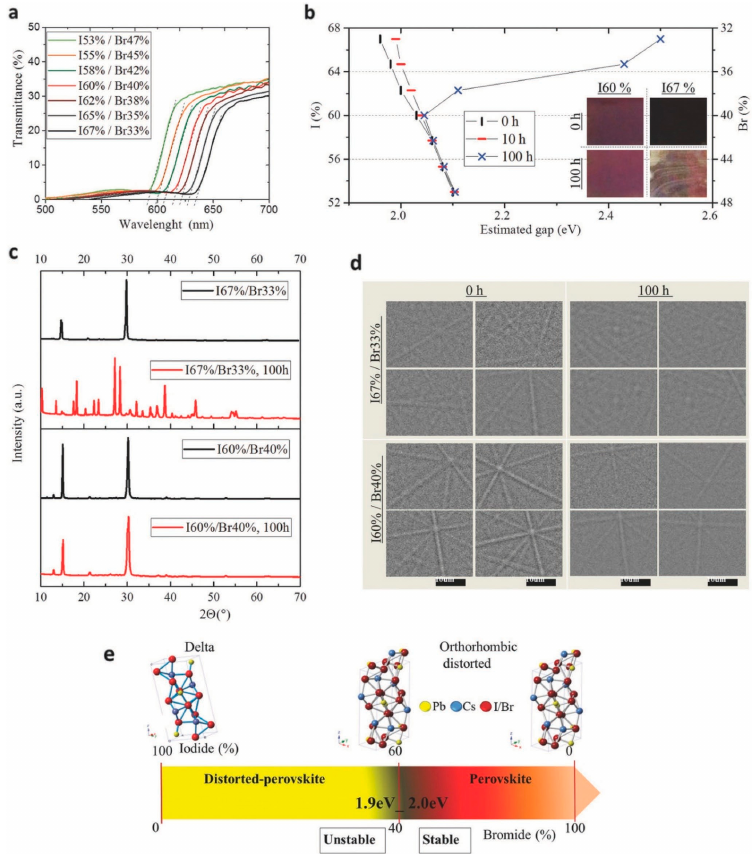
Figure 7. ( a ) Optical transmittance spectra of cesium lead ‐ halide inorganic perovskite thin films at various I/Br ratios; ( b ) Estimated bandgap calculated from the intersection of the wavelength axis (dashed lines) with short ‐ wavelength decay of the transmittance plot. Inset displays the images of freshly synthesized perovskite films and post storage for 100 h duration under ambient conditions;